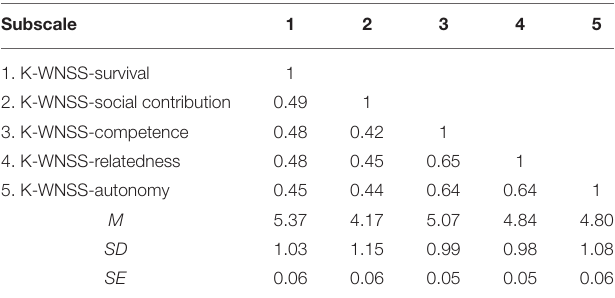
TABLE 3 | Correlations between the K–WNSS subscales and descriptive information ( N = 339 ).